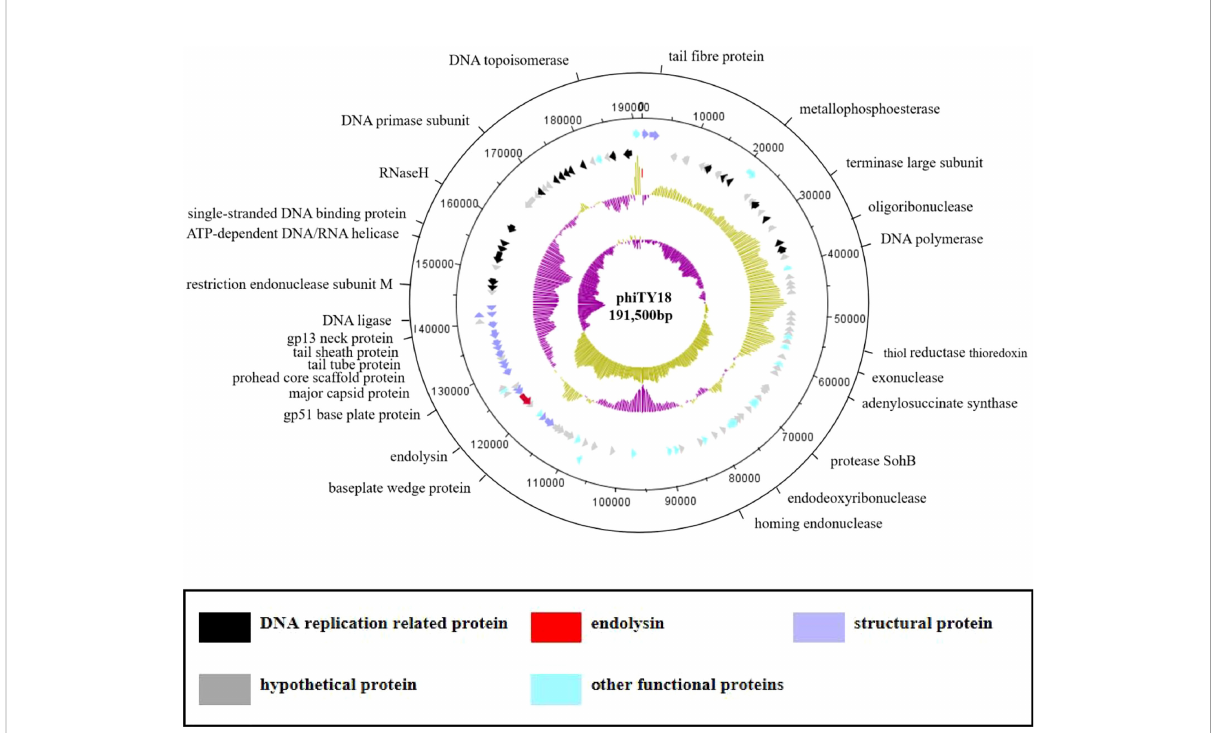
FIGURE 4 The genome map of bacteriophage phiTY18. The fi rst and second circles from the outside to the inside are the CDS on the positive and negative strands. The different colors represent different gene functions. The third circle indicates the GC content. The inward and outward parts denote a lower GC content and higher GC content in the region compared to the average GC content of the whole genome, respectively. The fourth circle represents the GC-Skew value; GCskew>0 indicates the leading chain, while GCskew< 0 indicates the lag